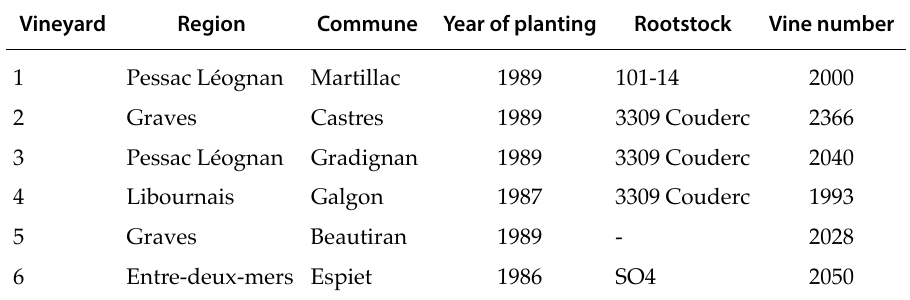
Table 1. Characteristics of the six monitored vineyards located in the bordeaux region (France). Vineyard Region Commune Year of planting Rootstock Vine number 1 Pessac Léognan Martillac 1989 101-14 2000 Graves Castres 1989 3309 Couderc 2366 Pessac Léognan Gradignan Libournais Galgon 1987 3309 Couderc Graves beautiran 1989 - 2028 Entre-deux-mers